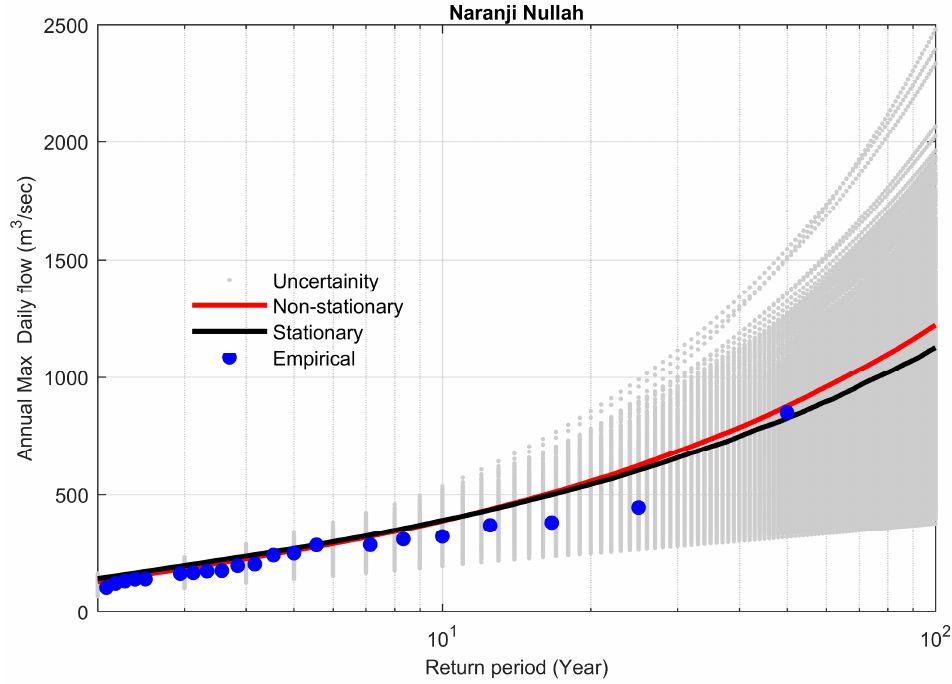
Figure 12. Comparison between non-stationary and stationary FFCs at site 16, along with non- stationary uncertainty bounds for the year 2016.